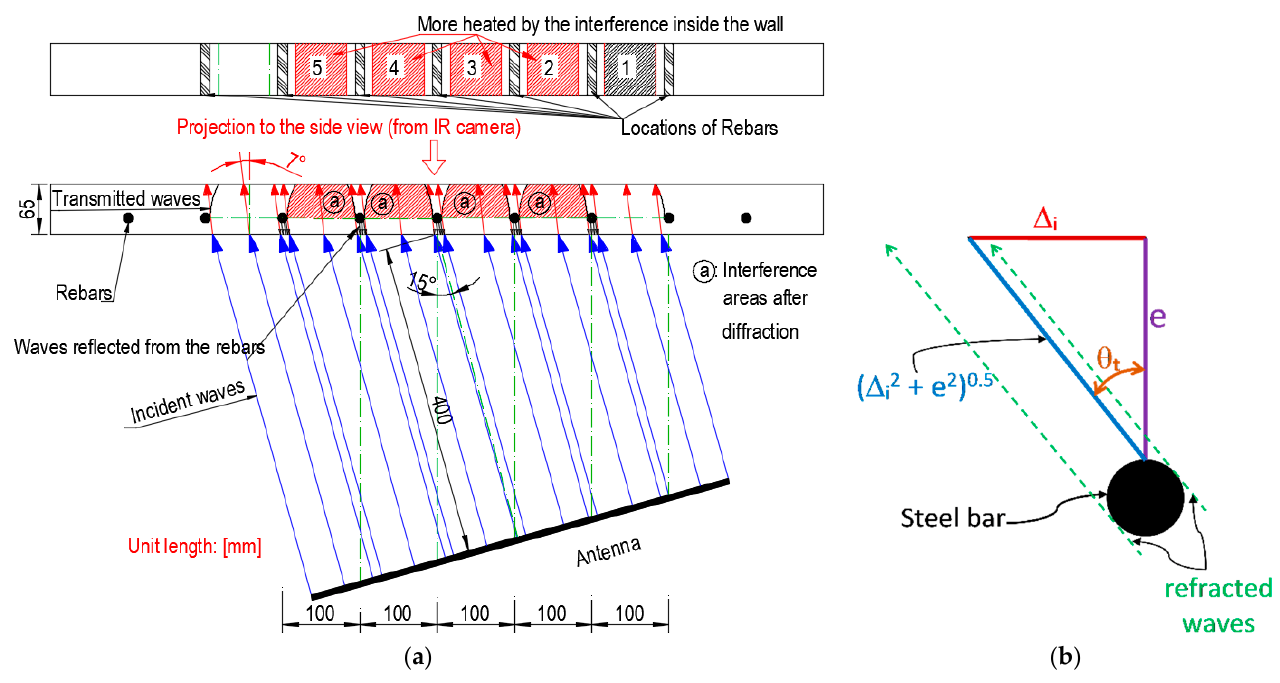
Figure 2. Refraction of wave by Snell—Descartes’s law.